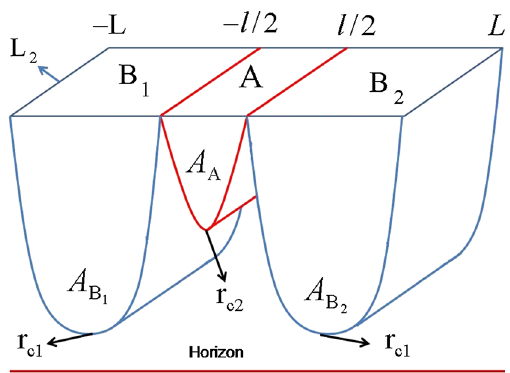
Fig. 2 Schematic of static minimal surfaces anchored on the subsys- tems A , B 1 and B 2 in the low temperature regime